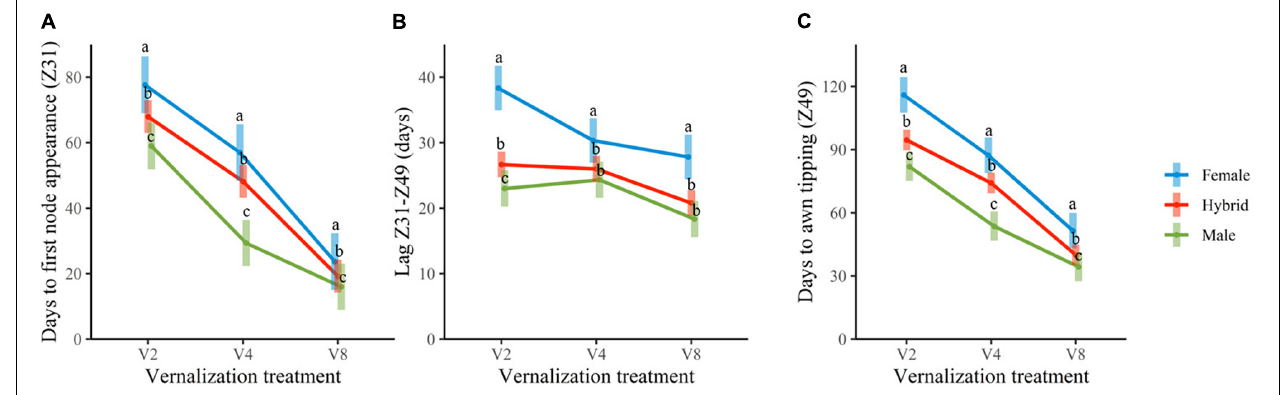
FIGURE 1 | From left to right, the average duration of time until Z31, (A) , lag Z31–Z49 (B) , and total time until Z49 (C) , for the three groups of genotypes, male parents, female parents, and hybrids. Error bars are 95% CIs. For each developmental variable and treatment, group means with a different letter are significantly different at P < 0.05 according to the contrasts performed for the overall